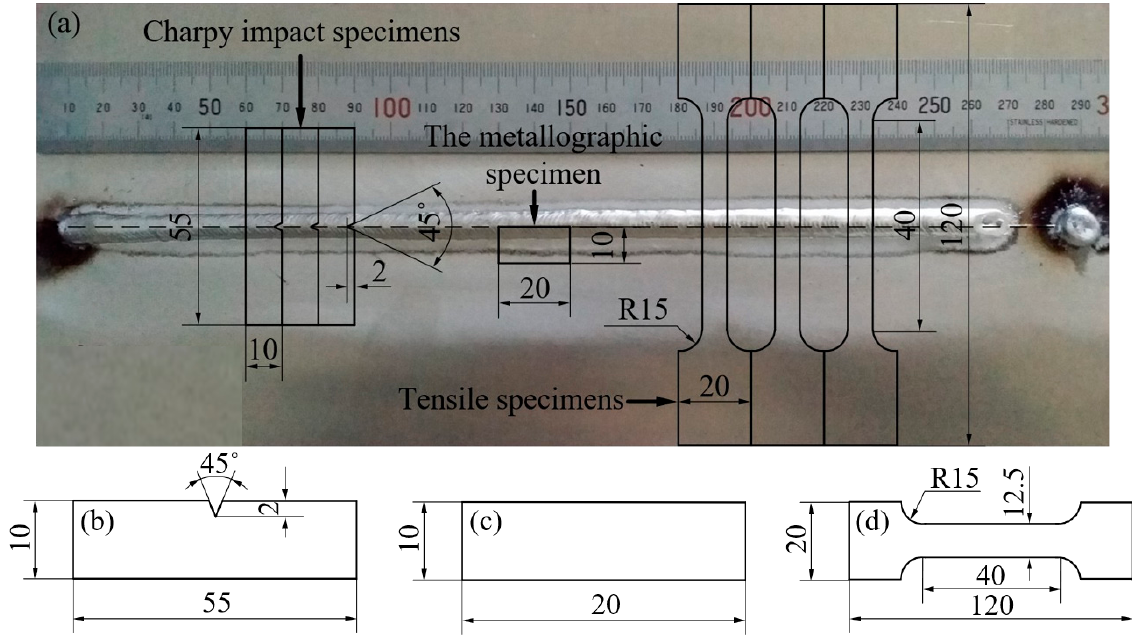
Figure 4. Dimensions of the test specimens (unit: mm): ( a ) extraction locations on each butt joint to obtain the test specimens, ( b ) Charpy impact specimens, ( c ) the metallographic specimen, ( d ) tensile